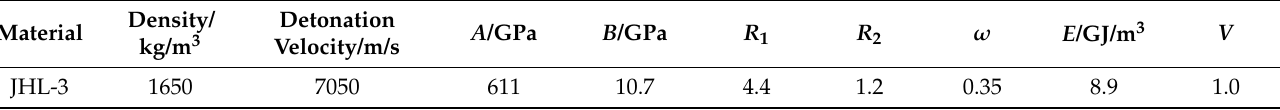
Table 2. Material parameters of explosives [28].